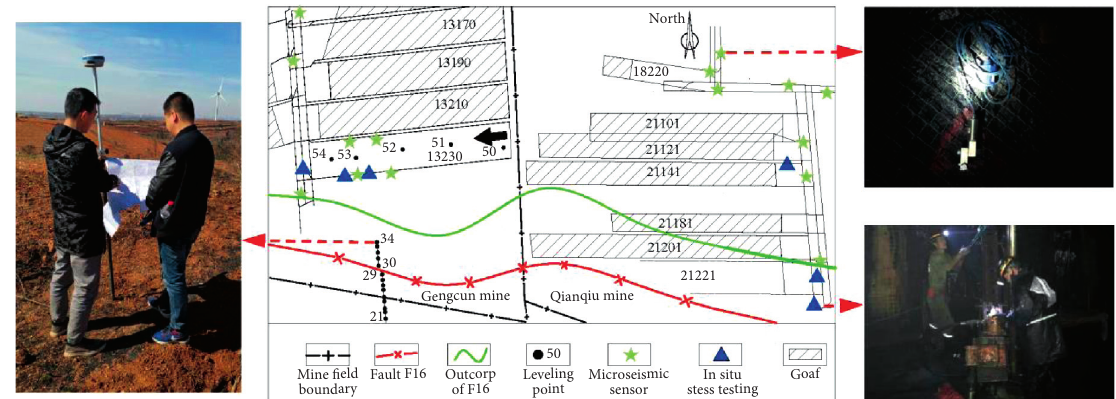
Figure 7: The distribution of working face and integrated-united monitoring in the Gengcun-Qianqiu area.